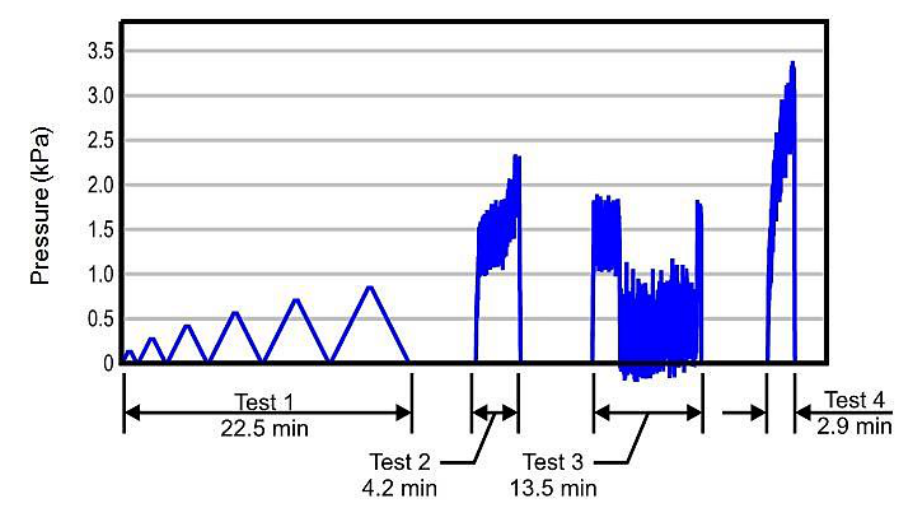
Figure 4. Pressure time history.